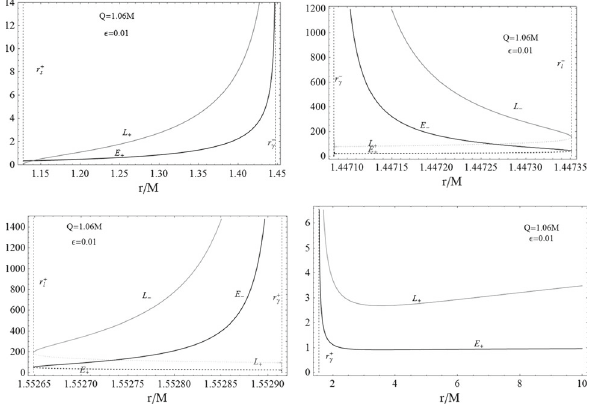
√ √ Fig. 18 Class : ( 3 6 / 7 ) M ≤ Q ≤ 9 / 8 M and0 < (cid:2) ≤ (cid:2) l Parameter choice is as follows: Q = 1 . 06 M and (cid:2) = 0 . 01. Then (cid:2) l = 0 . 0998397, = 1 . 44735 M , r + s = 1 . 12756 M , r − γ = 1 . 44708 M , r + γ = 1 . 55292 M r − l = 1 . 55265 M .Circularorbitsexistwithangularmomentum L = and r + l L − ( gray curve ) and energy E = E − ( black curve ) in r − γ ≤ r ≤ r − ; l L = 0 at r = r + s ( upper left plot ); L = L ± in r + s < r < r − ( upper l ≤ r < r + = L − in r ≥ r + right plot ) and r + γ ( bottom left plot ); L γ l ( bottom right plot